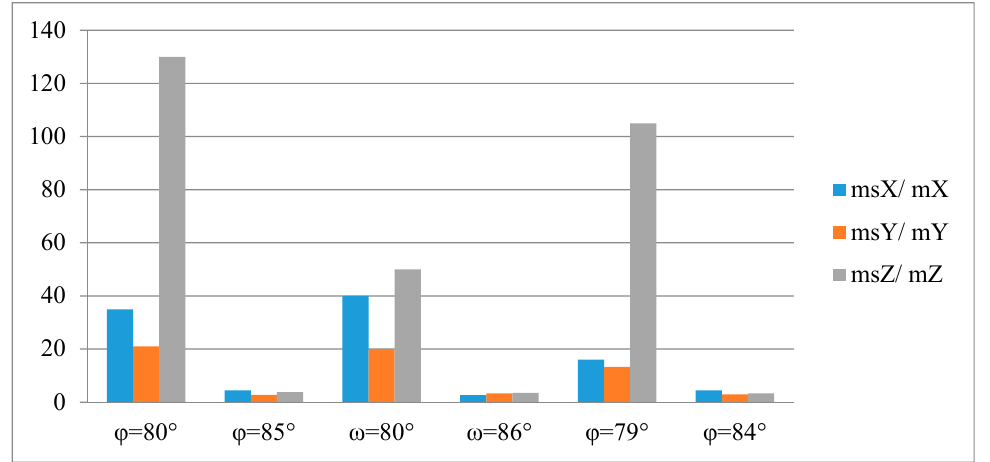
Figure 11. Ratios of the RMSE of the point coordinates calculated using simplified set of collinearity equations to the RMSE of the point coordinates calculated using classic collinearity equations for configuration II.